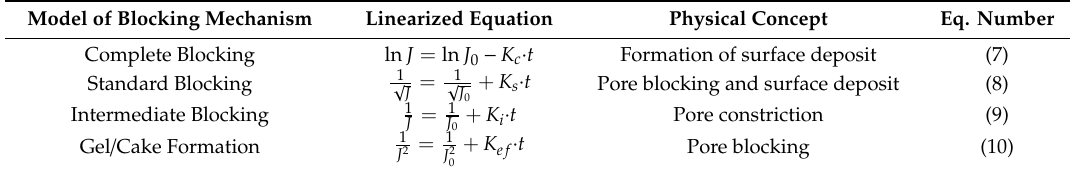
Table 1. Linearization equation of blocking / fouling models based on Hermia’s